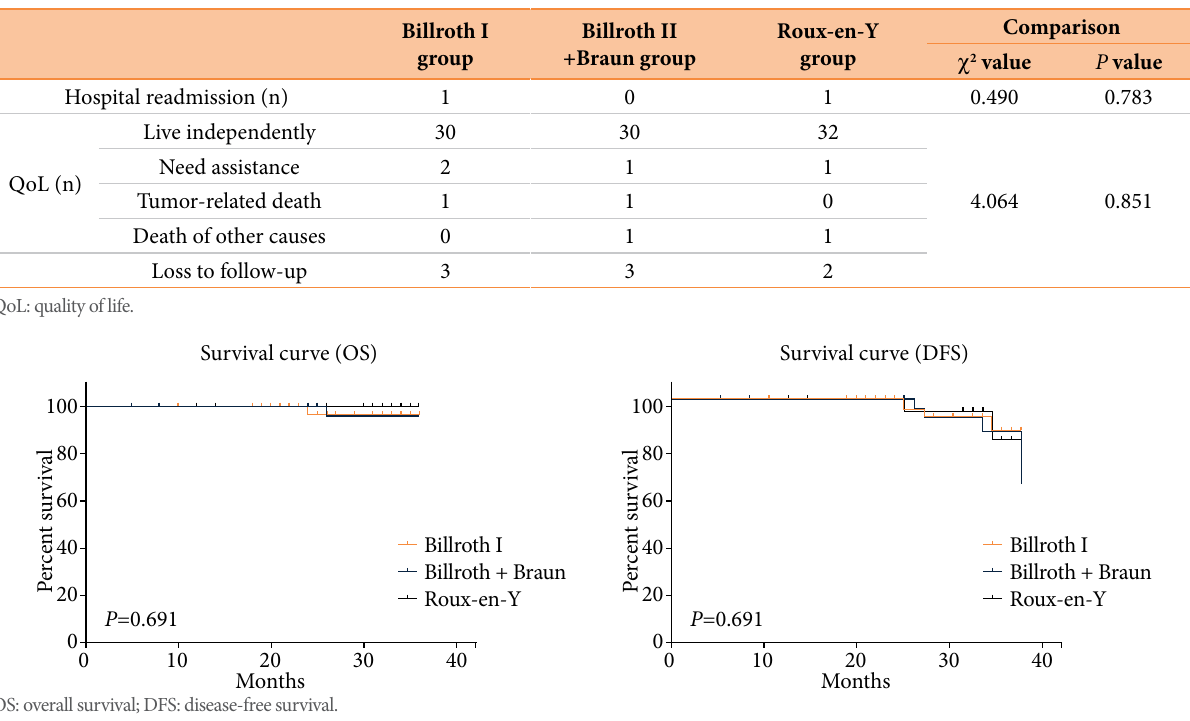
Figure 2 - Comparison of survival curves among the three